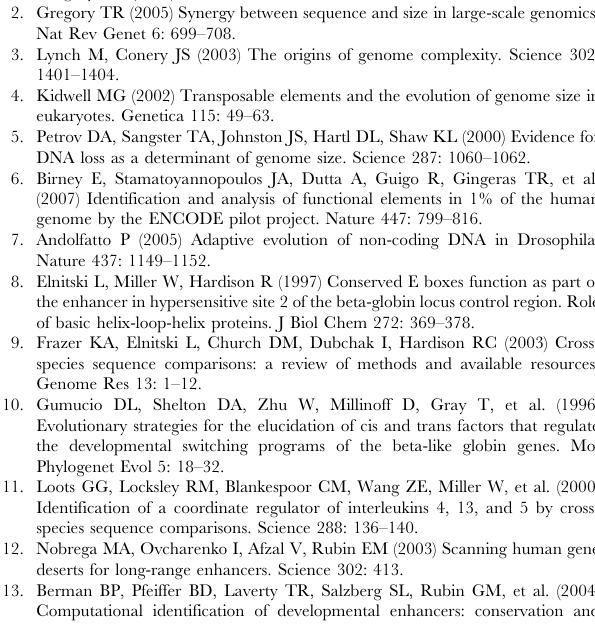
Table S4 Sequenced